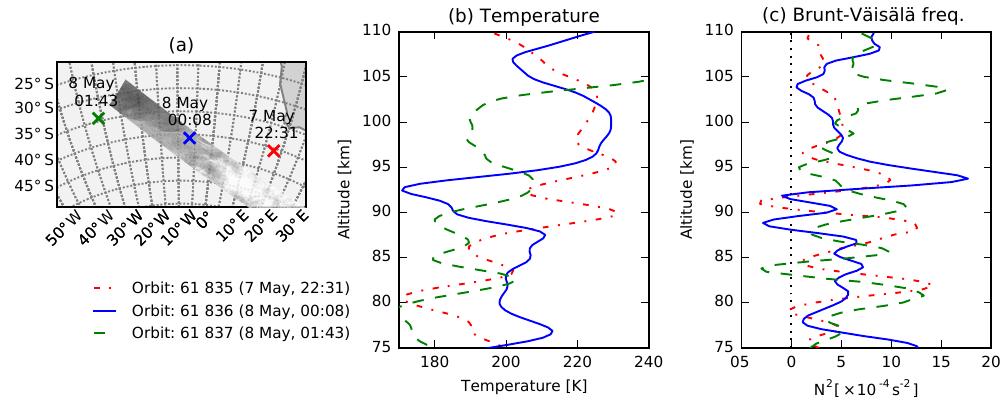
Figure 4. SABER measurements obtained from 7 May at 22:31UT to 8 May at 01:43UT. (a) The measurement points at 95km are indicated by crosses. (b) The altitude profiles of temperature. (c) The altitude profiles of Brunt–Väisälä frequency.